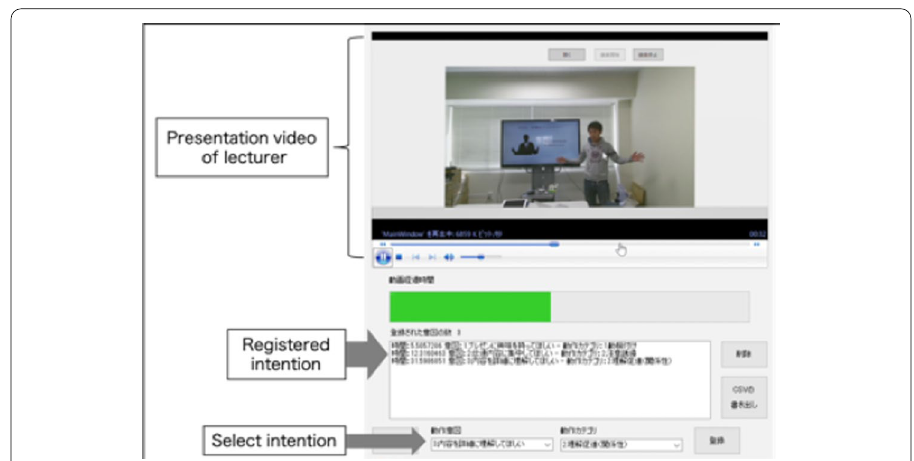
Fig. 6 User interface for intention